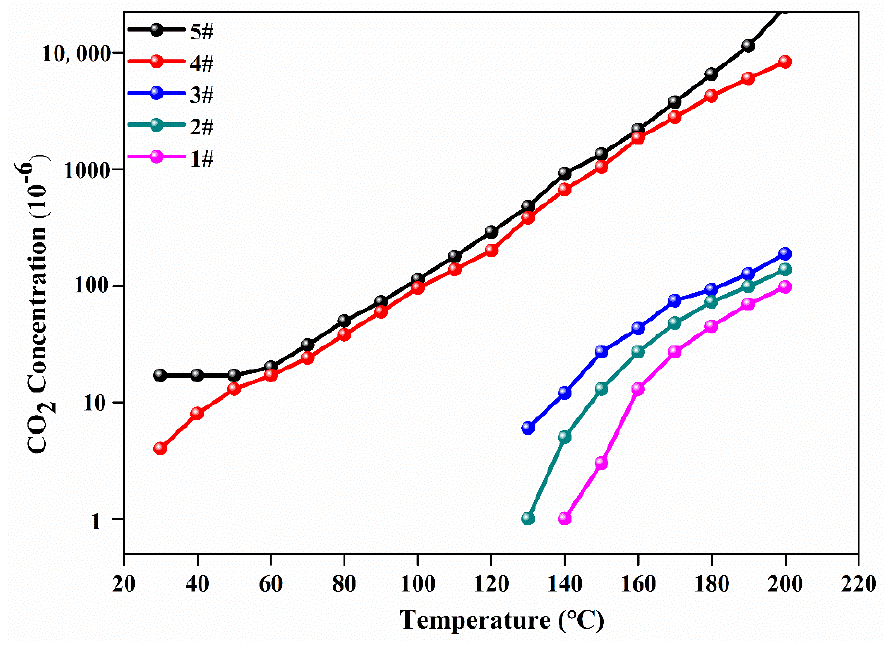
Figure 5. CO 2 generation curves with different oxygen concentrations.